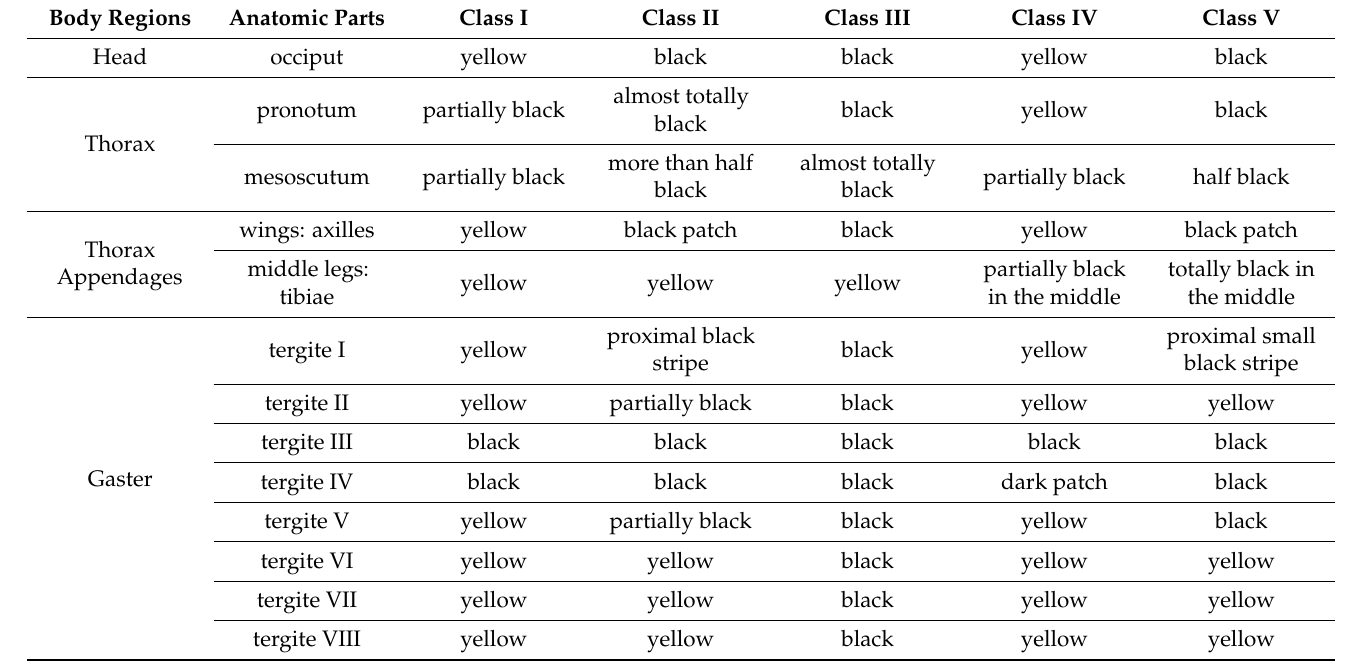
Table 1. Coloration of body parts detected in females of Cirrospilus pictus grouped in the assigned chromatic classes I = yellow females, II = yellow–black females, III = black females, IV = yellow males, V = black males. All classes are observed in dorsal view.